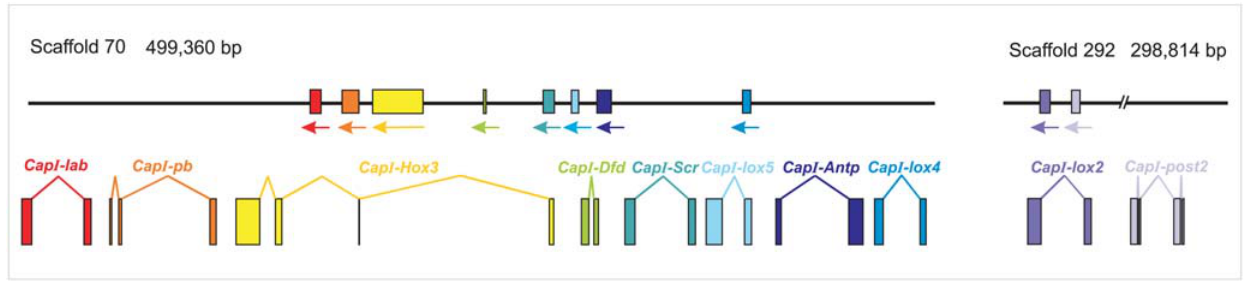
Figure 2. Genomic organization of the Capitella sp. I Hox cluster. A total of 11 Capitella sp. I Hox genes are distributed among three scaffolds. Black lines depict two scaffolds, which contain 10 of the Capitella sp. I Hox genes. The eleventh gene, CapI-Post1 , is located on a separate scaffold surrounded by ORFs of non- Hox genes (unpublished data). No predicted ORFs were identified between adjacent linked Hox genes. Transcription units are shown as boxes denoting exons, connected by lines that denote introns. Transcription orientation is denoted by arrows beneath each box. Color coding is the same as that used in Figure 1 for each ortholog.